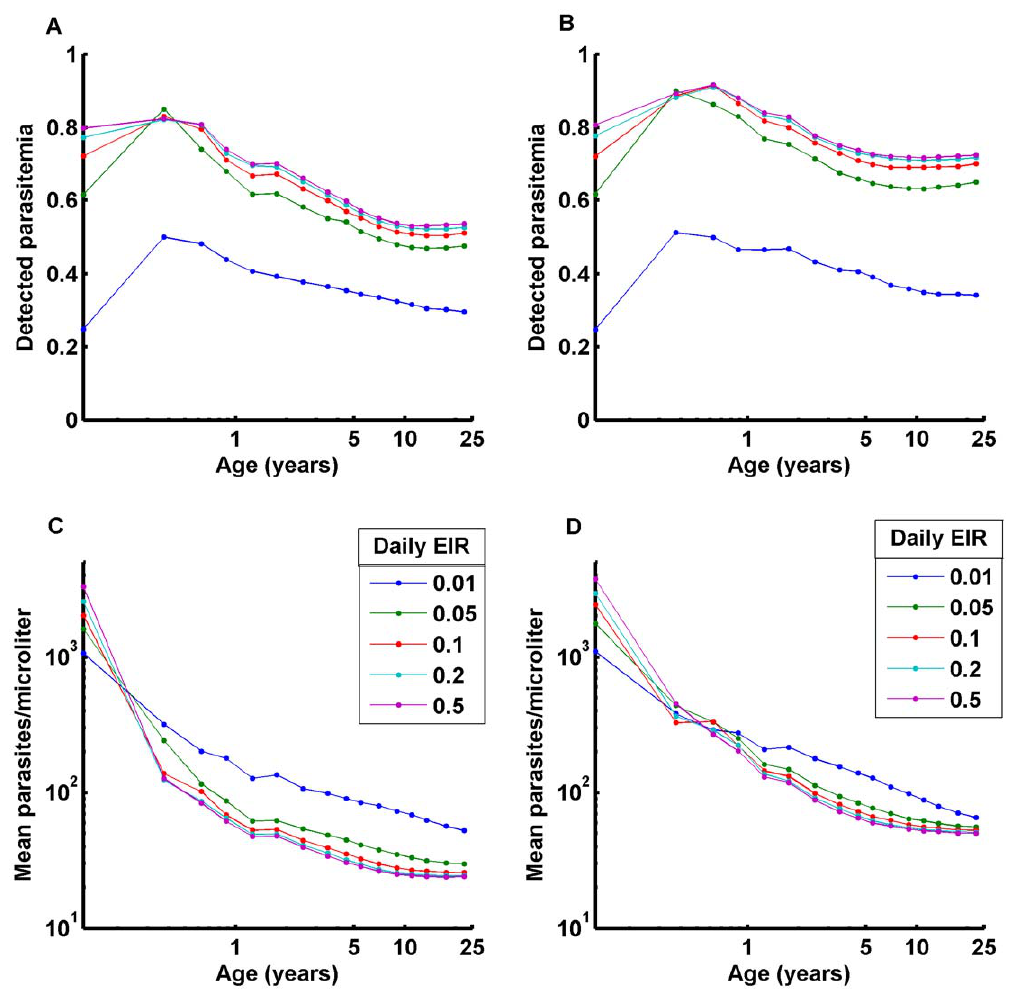
Figure 8. Age prevalence studies for different parasite population antigenic diversity. Age prevalence studies for A) detected parasitemia; B) geometric mean parasitemia binned by age range for a parasite population with each infection having 50 of 300 PfEMP-1 variants, 1 of 4 MSP-1 variants, and 1 of 4 sets of 5 minor epitopes; C,D) the same analysis for a parasite population with 300 PfEMP-1 variants, 10 MSP-1 variants, and 10 sets of 5 minor epitopes. Immunity takes longer to develop with a more varied parasite population.